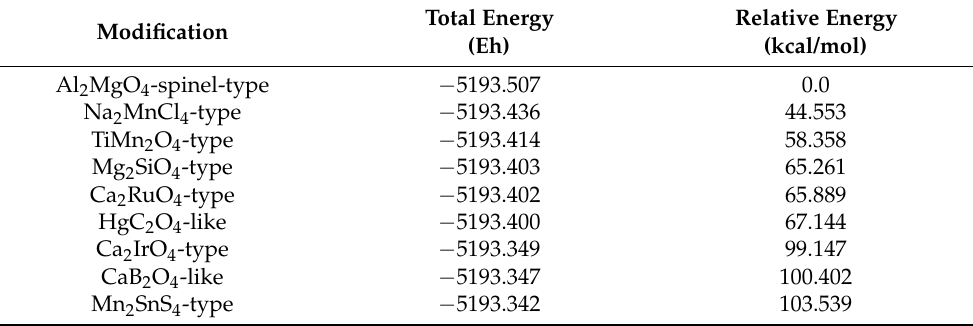
Table 4. The total energy and relative energy values compared to the global minimum (spinel structure taken as the zero of energy) of Cr 2 SiN 4 modifications obtained from DM-based searches and calculated using GGA-PBE.